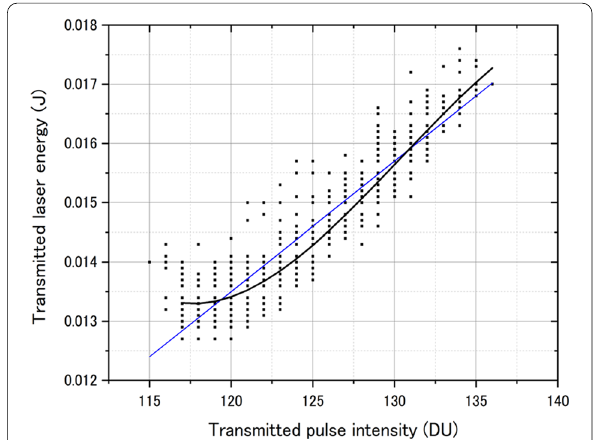
Fig. 10 E T and D T . The third polynomial equation is adopted as the conversion function of the transmitted energy (thick black line). The straight blue line is previously derived by Yamada et al.